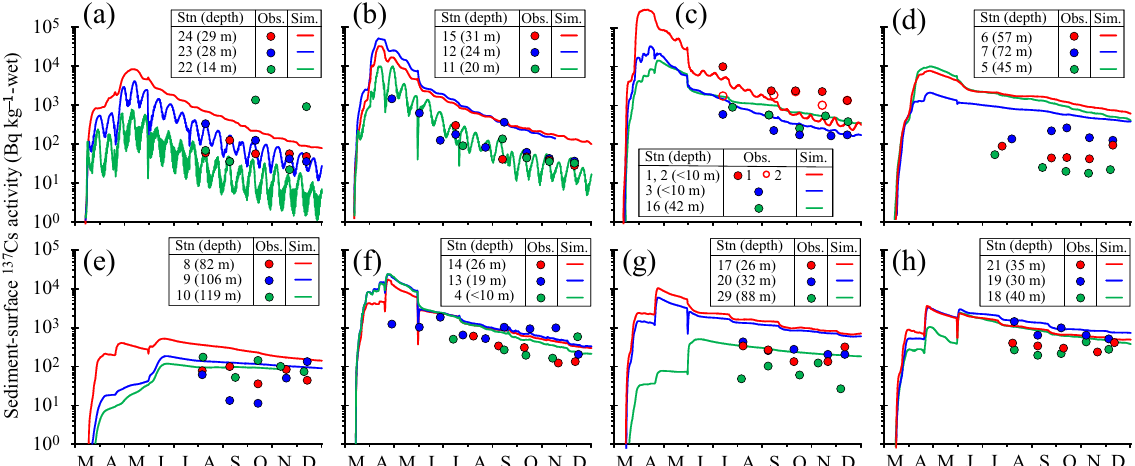
Figure 7. Time series of observed (circular plots) and simulated (lines) sediment-surface 137 Cs at TEPCO (2011) stations. Locations of observations are shown in Fig. 1c. Longitude axis has units Bqkg − 1 -wet. Water depths are according to JTOPO30 (MIRC).